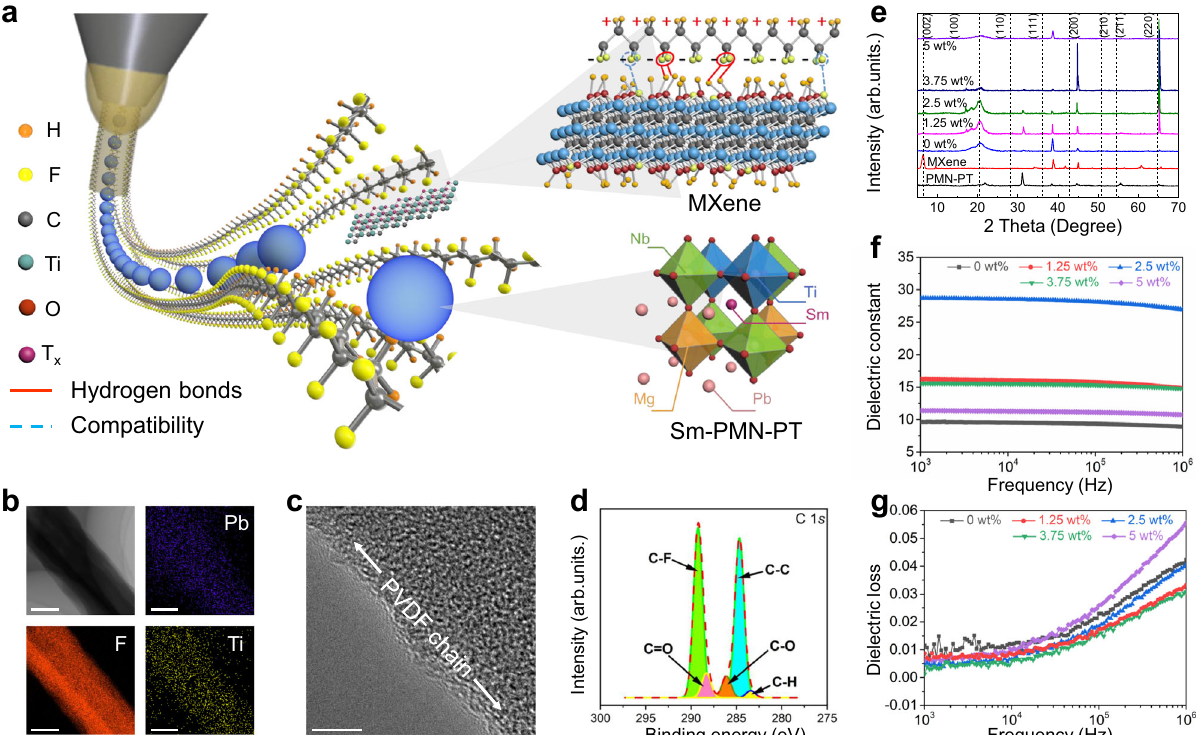
Fig. 2 | Structure design and characterization of the MXene-enabled piezo- electric composite (MPC) based soft piezoelectric textile (PT). a Schematic illustration of electrospinning procedure for MPC textiles synthesis. Inset: Inter- molecular interaction between MXene and PVDF; and 2×2×2 supercell of Sm- PMN-PT as a ceramic fi ller. b Scanning electron microscope (SEM) images and Energy-dispersivespectrometer(EDS)mappingspectraofPb,F,andTielementsin theas-preparedcomposite fi lm.Scalebars:200nm. c HighresolutionSEMimageof